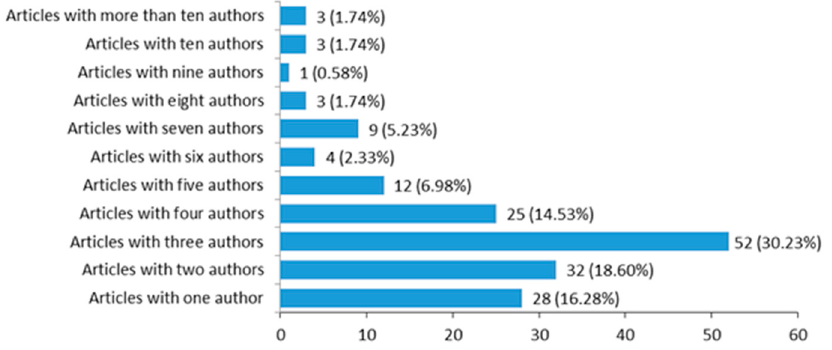
Figure 4. Collaboration. Source: own elaboration.